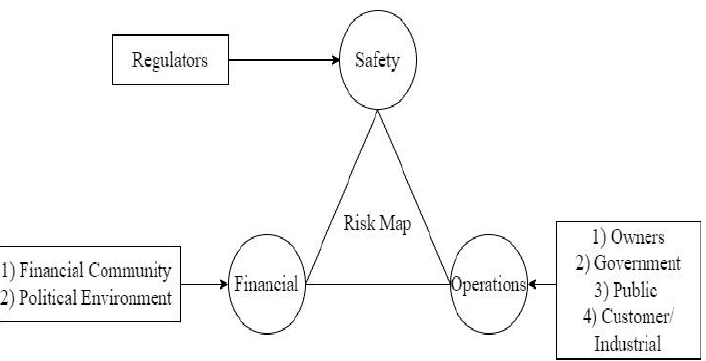
Figure A1 . Risk management environment model for a nuclear power plant operator . Figure A1. Risk management environment model for a nuclear power plant